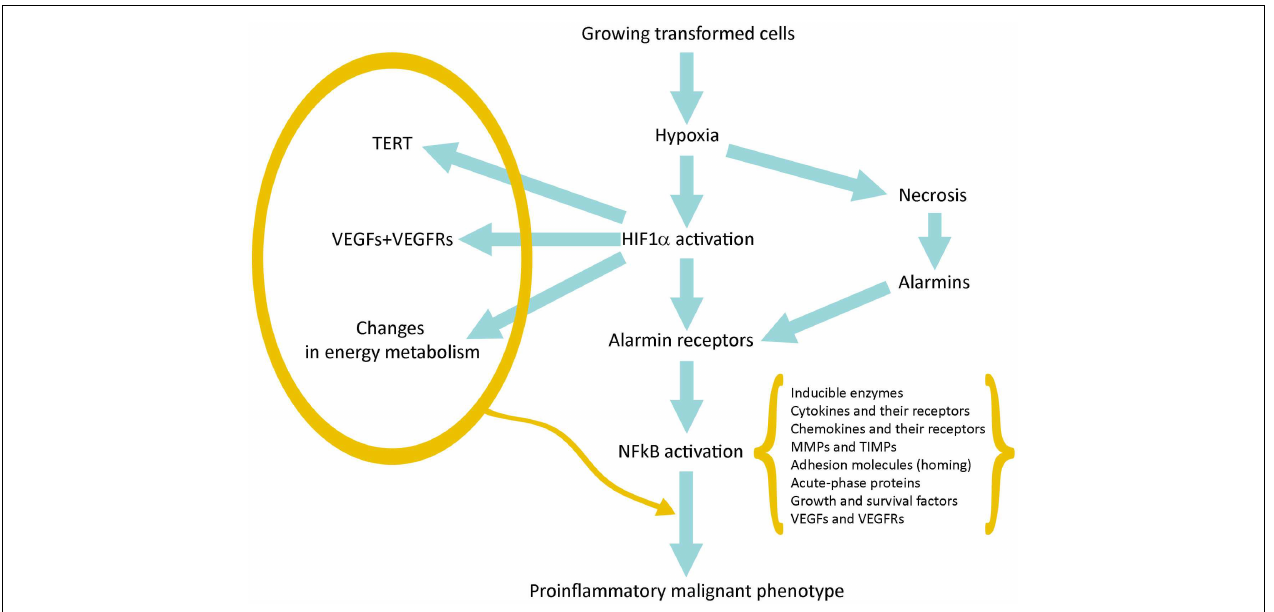
FIGURE 1 | Schematic representation of the pathway linking hypoxia and HIF1 α activation with inflammation and tumor progression.